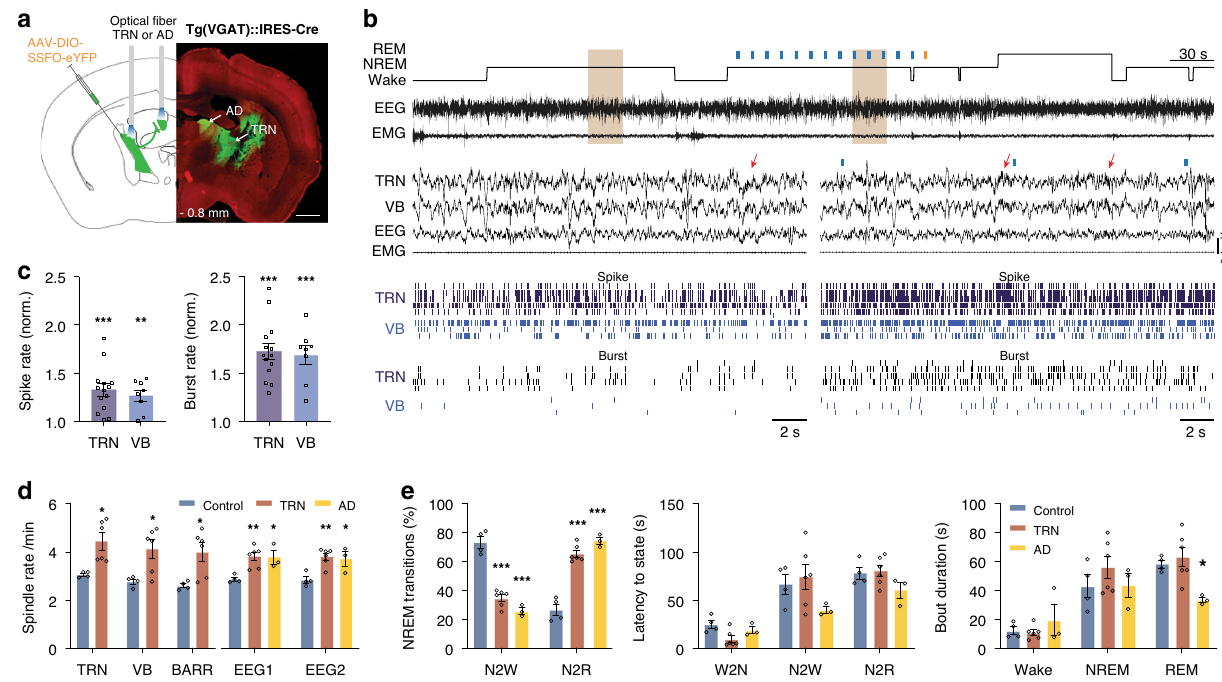
Fig. 5 Optogenetic activation of TRN VGAT cells or TRN-AD terminals increases spindle rate and probability of transitions to REM sleep. a Schematic representation of stereotactic injection of a EF1 α -DIO-SSFO-EYFP adeno-associated virus in the anterior TRN of VGAT::IRES-Cre driver mice, and bilateral optic fi ber placement in TRN or AD. b Representative EEG/EMG and thalamic LFP/unit/burst activities during NREM sleep episodes outside and within stimulation of TRN VGAT cells. The brown-shaded areas in the top traces are expanded below. Red arrows indicate the detected spindles. c Quanti fi cation of single-unit and burst fi ring of TRN ( n = 14 cells) and VB ( n = 8 cells) neurons during TRN activation, normalized to the baseline condition. Both single-unit and burst fi ring of TRN and VB neurons signi fi cantly increased as compared to baseline (TRN stimulation vs. control: TRN: unit: P = 0.0002; t = 5.1; d.f. = 13; burst: P < 0.0001; t = 8.8; d.f. = 13; n = 14 cells, 6 animals; VB: unit: P = 0.003; t = 4.4; d.f. = 7; burst: P = 0.0002; t = 7.0; d.f. = 7; n = 8 cells, 6 animals; two-sided paired t -test; ** P < 0.01, *** P < 0.001). d Spindle rate signi fi cantly increases upon optogenetic activation of TRN VGAT neurons or their terminals within AD (TRN stimulation vs. control: TRN: P = 0.032, VB: P = 0.035, BARR: P = 0.041, EEG1: P = 0.004, EEG2: P = 0.009; AD stimulation vs. control: EEG1: P = 0.013, EEG2: P = 0.016; F = 4.48; d.f. = 4; two-way ANOVA with Tukey ’ s post-hoc test; * P < 0.05, ** P < 0.01; n = control:4, TRN:6, AD:3 animals). e Averaged NREM sleep transitions (left), latency to next states (middle) and bout duration upon SSFO activation of TRN (red), AD (yellow), or control (blue; TRN or AD stimulation vs. control: NREM transitions: P < 0.0001 for N2R and N2W; F = 0.82; d.f. = 2; latency to vigilance state: P > 0.05 for all states; F = 1.7; d.f. = 4; two-way ANOVA with Tukey ’ s post-hoc test; * P < 0.05, ** P < 0.01, *** P < 0.001; n = control: 4, TRN:6, AD:3 animals). All values are reported as mean ± SEM. Source data are provided as a Source Data fi step-function opsin (SSFO) to TRN neurons, and their terminals located in AD, by stereotactic injection of a EF1 α -DIO-SSFO- EYFP or EF1 α -DIO-EYFP (control) adeno-associated virus (AAV) in the anterior TRN of VGAT::IRES-Cre driver mice